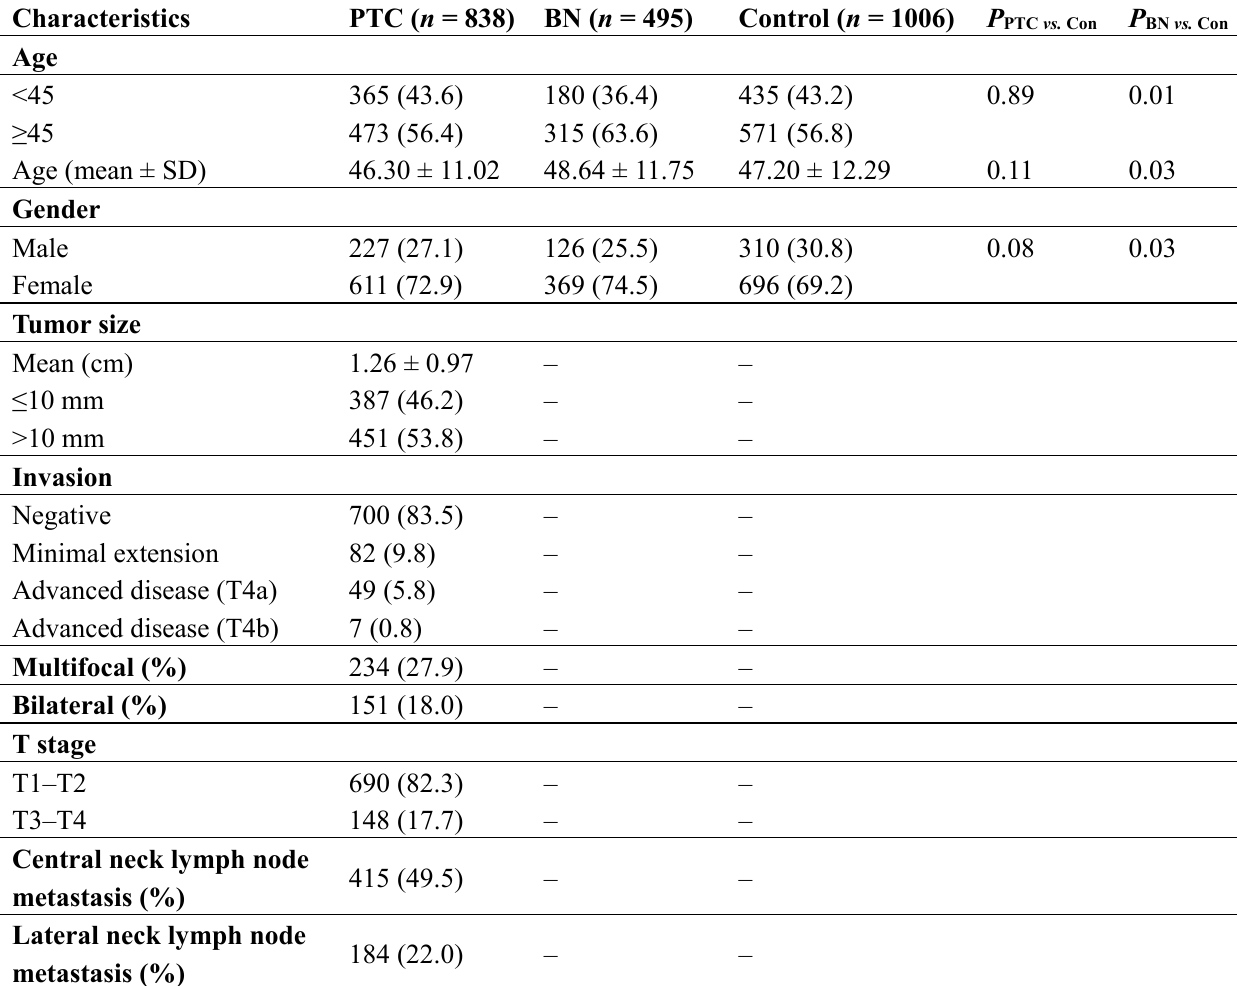
Table 1. Characteristics of the study